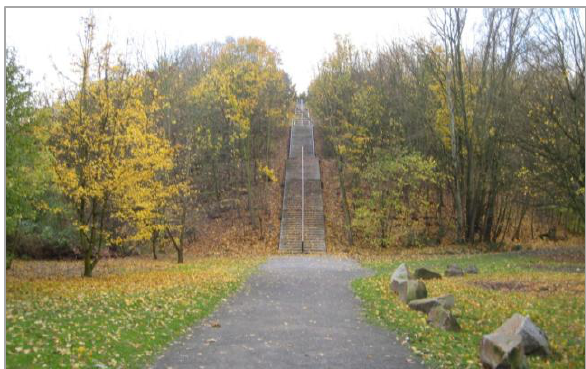
Fig. 1. Rheinelbe mine tip in Gelsenkirchen ( M. Chmielewska, 2008)